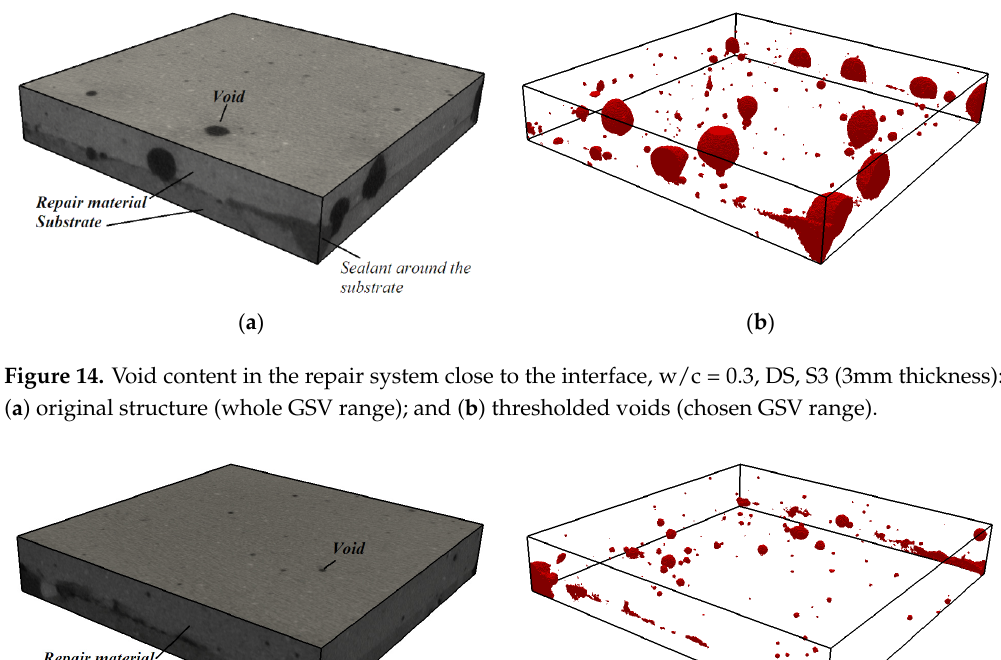
( b ) Figure 13. CT scan images for specimens w/c = 0.3, DS, S3 and w/c = 0.3, WS, S3 made at the age of 3 d: ( a ) section II ‐ II (Figure b), front view; and ( b ) section I ‐ I (Figure a), top view. The moisture exchange between the repair material and substrate seems to have a significant influence not only on the effective w/c, degree of hydration and uniformity of properties of the repair material and interface, but also on void content close to the interface. The void content in two samples is compared in Figure 16. Significantly more voids are observed when the substrate is dry. Dry substrate absorbs water from the repair material (Figure 9a). When the water is absorbed, air from the substrate is being released. This air stays entrapped at the interface resulting in high void content. It was also observed that voids from the substrate are “initiation” points for voids in the repair